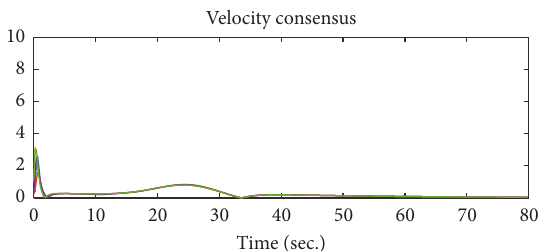
Figure 7: Multiagent velocity trajectory in the scenario with